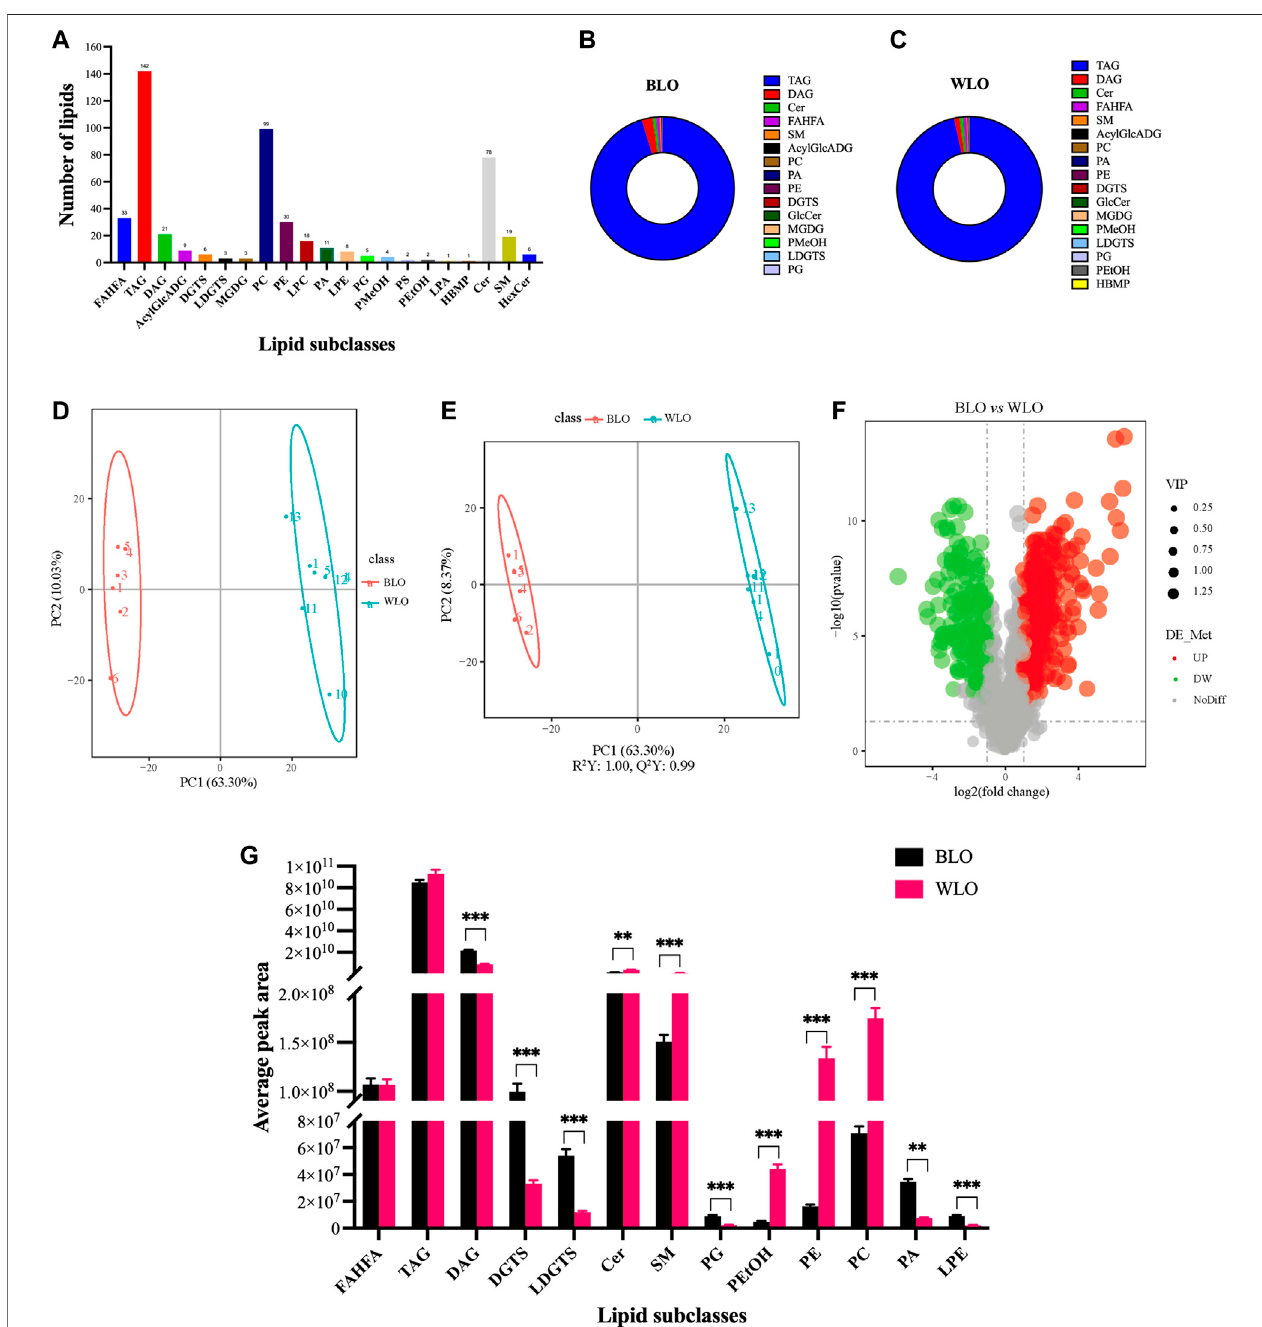
FIGURE 3 | Lipidomic studies by UPLC-MS/MS on the lipid constituents of BLO and WLO. (A) : The number of lipids detected and annotated in BLO and WLO. (B,C) :ThecompositionoflipidsdetectedandannotatedinBLOandWLO. (D,E) :MultivariatedataanalysisofUPLC-MS/MSdataofBLOandWLO.Scorescatterplotof the PCA (D) and OPLS-DA (E) derived from the UPLC-MS/MS data of BLO and WLO lipidomic pro fi les. (F) : Volcano plot showing the different lipids between BLO and WLO. (G) : Differences in the signi fi cantly different lipid subclasses between BLO and WLO. ** p < 0.01, *** p < 0.001.